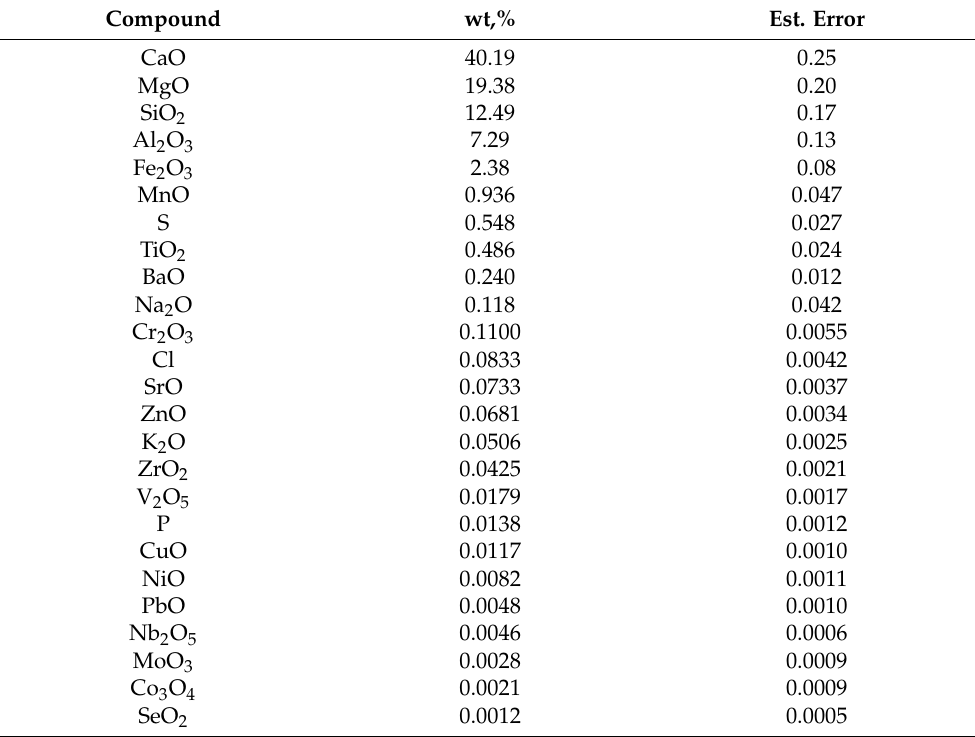
Table 2. Results of the X-ray fluorescence of ladle furnace